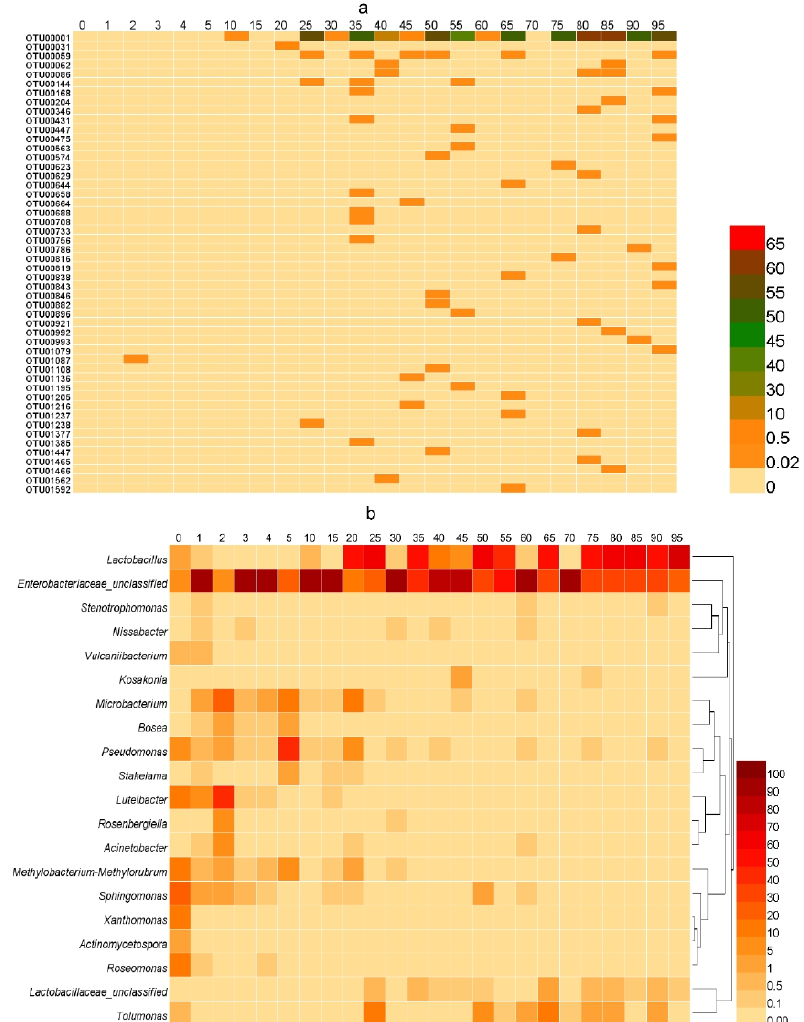
Figure 6. The proportion of microbial community in sour tea at different fermentation times. ( a ) The proportion of OTUs belonging to Lb. plantarum in the sour tea fermentation process. The proportion of Lb. plantarum in unfermented sour tea was very low. Lb. plantarum accounted for only 5% 20 days before the fermentation of sour tea. Lb. plantarum accounted for 56% on the 25th day of fermentation. The highest proportion of Lb. plantarum was 64% on the 85th day of fermentation. ( b ) Heatmap showing changes in the microbial community of sour tea during fermentation. The top 20 bacteria were selected for their relative abundance at the genus